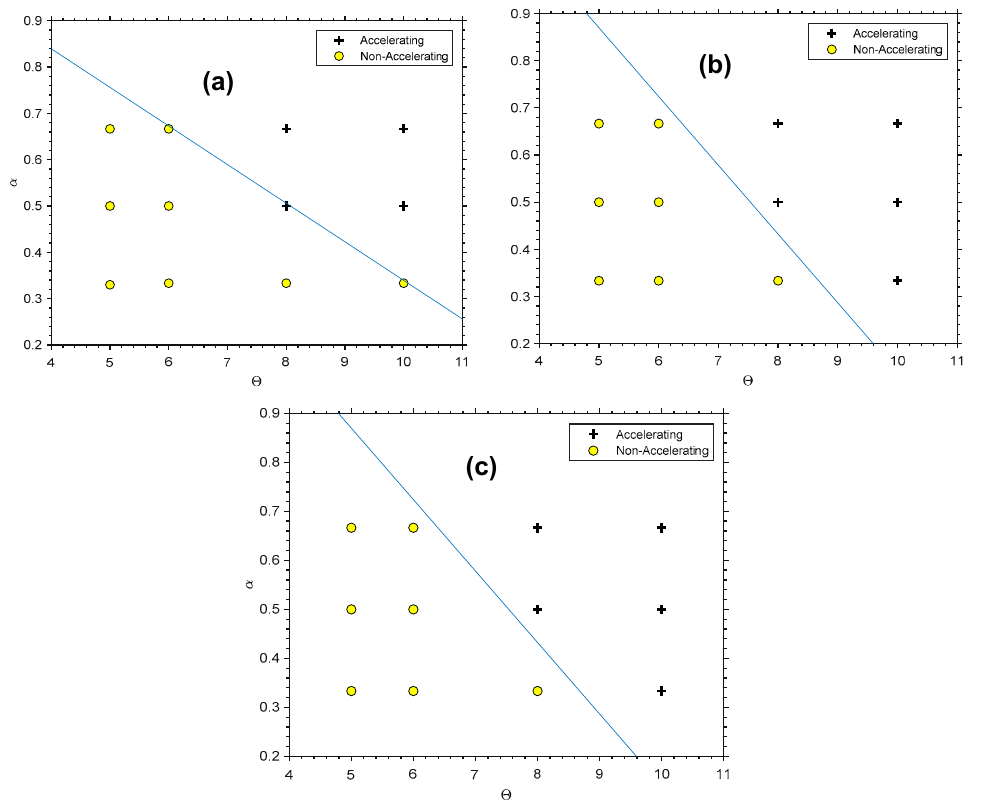
Figure 16. The α − Θ burning regime diagram—for Re = 24 ( a ) Re = 36 ( b ) and Re = 48 ( c Figure 16. The 𝛼 − Θ burning regime diagram — for 𝑅𝑒 = 24 ( a ) 𝑅𝑒 = 36 ( b ) and 𝑅𝑒 = 48 ( c ).